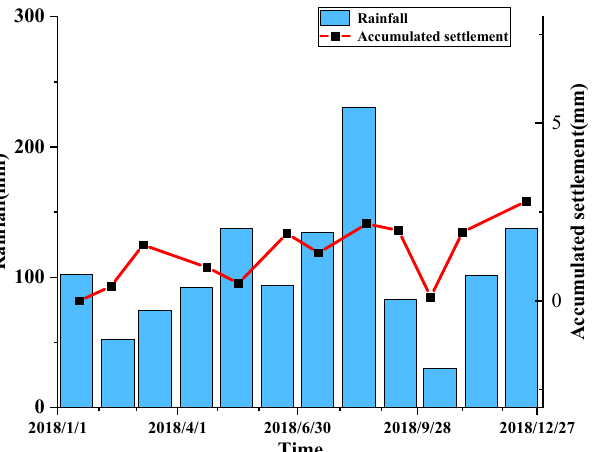
Figure 9. QX2 Comparison of Precipitation and Subsidence of National Meteorological Station.